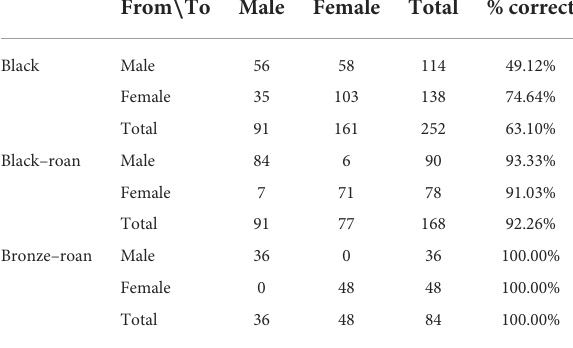
TABLE 5 Classification table for the estimated sexes according to different plumage varieties. From \